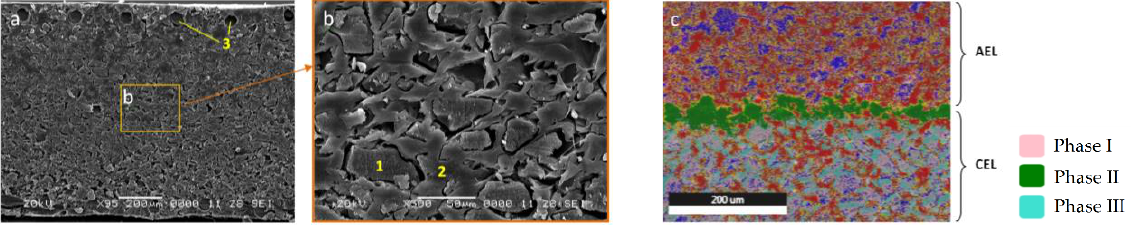
Figure 4. Cross section of the bipolar membrane MB-2-Cr: electron micrograph ( a , b ) and phase analysis ( c ). 1, Ionite particles; 2, polyethylene; 3, reinforcing fiber; AEL, anion-exchange layer; CEL, cation-exchange layer; I, II, III are phases with different composition. Table 2. Elemental composition of the phases.